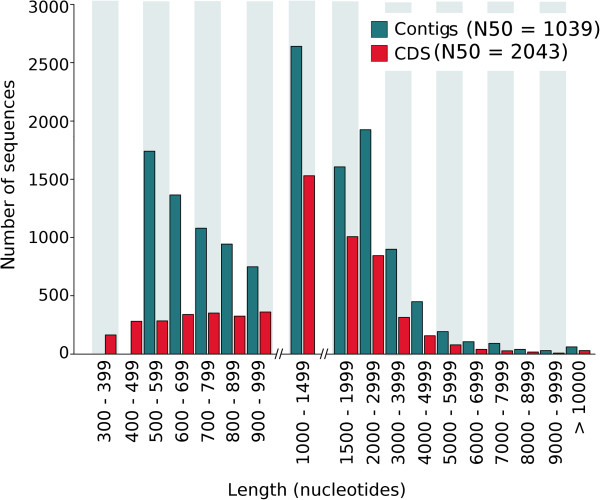
Nucleotide length distributions for the Musca domestica ALHF strain raw assembled contigs and predicted coding regions (CDS). Coding region lengths were predicted using Augustus (version 2.5.5) under the “fly” model and include both complete (5469 sequences) open reading frames (ORFs) and partial ORFs (690 sequences). A partial ORF means any sequence that is predicted to be missing either the start or the stop codon, but not both.